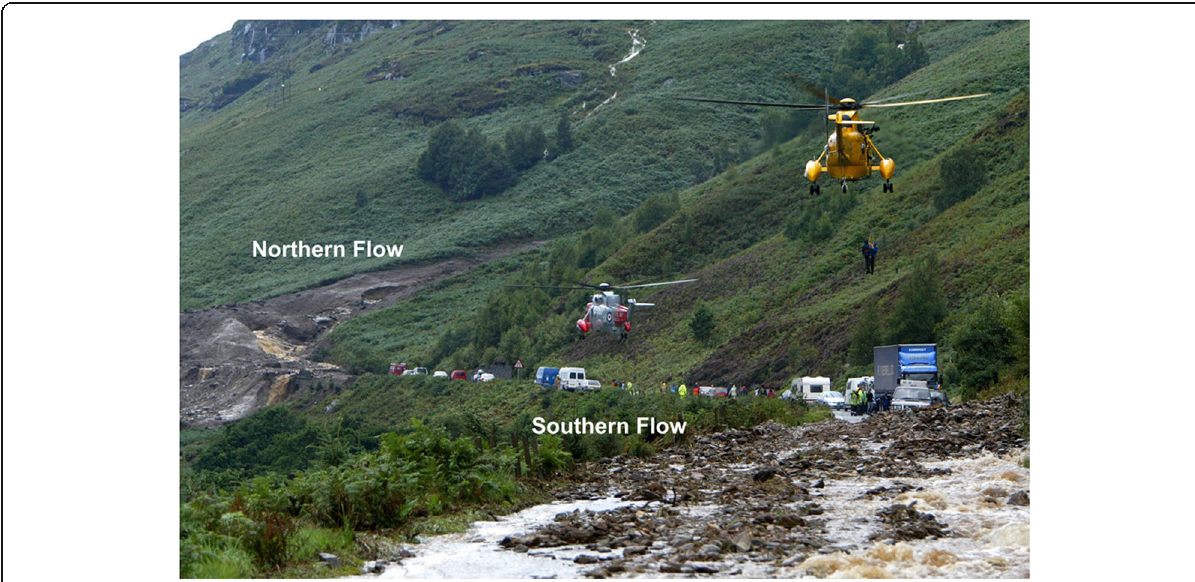
Fig. 6 Fifty-seven occupants of the 20 vehicles that were trapped between the two debris flows at the A85 in Glen Ogle were airlifted to safety. (© Perthshire Picture Agency: